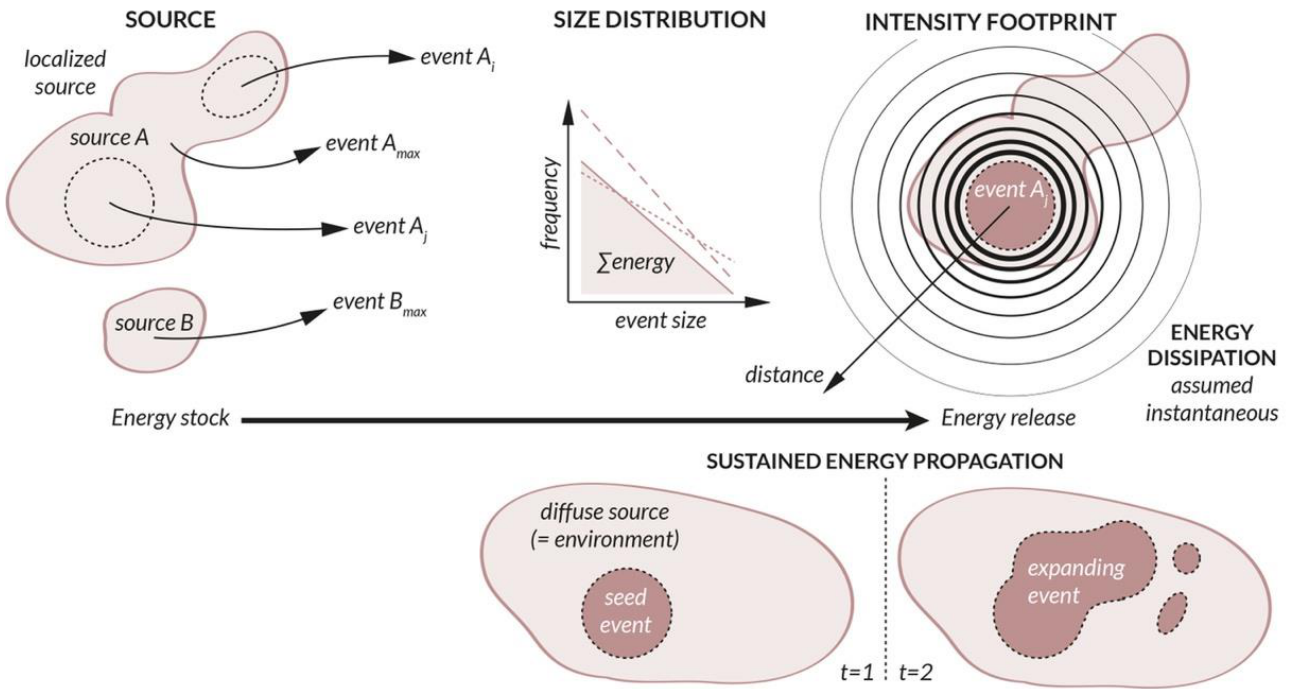
Figure 7. Sketch describing the hazard process in terms of energy transfer, applicable to any peril. See text for details.